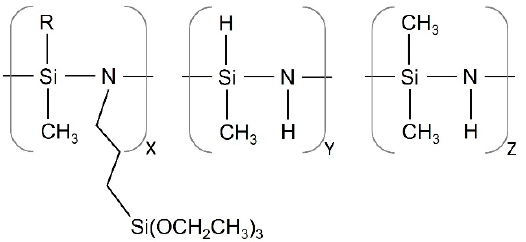
Figure1. Schematicrepresentationofpropyltriethoxysilyl-substitutedpolymethyl(hydro) / Figure 1. Schematic representation of propyltriethoxysilyl-substituted polymethyl(hydro)/polydimethylsilazane.